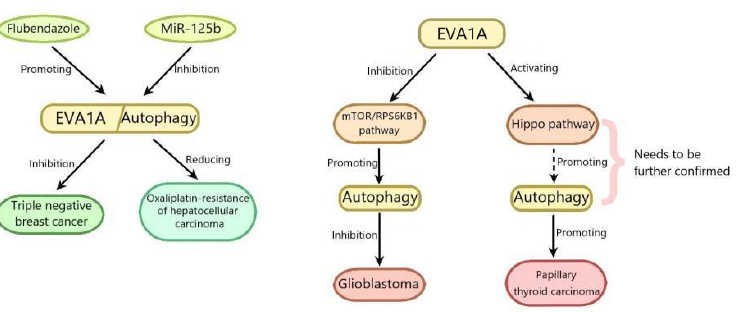
Figure 2. EVA1A plays an important role by regulating autophagy in the regulation of tumors. Contrary to the above, the enhanced EVA1A-regulated autophagy can inhibit tumors.